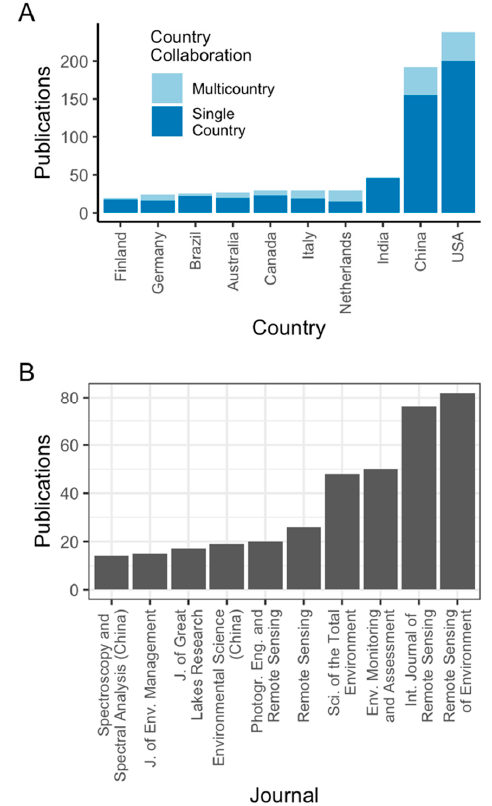
Figure 2. Distribution of publications returned from Scopus query for the top ten most productive countries ( A ) and top ten most published journals ( B ).